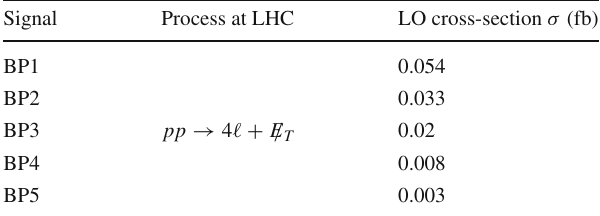
Table 15 The LO cross-sections for the signal pp → 4 (cid:3) + E T / Signal Process at